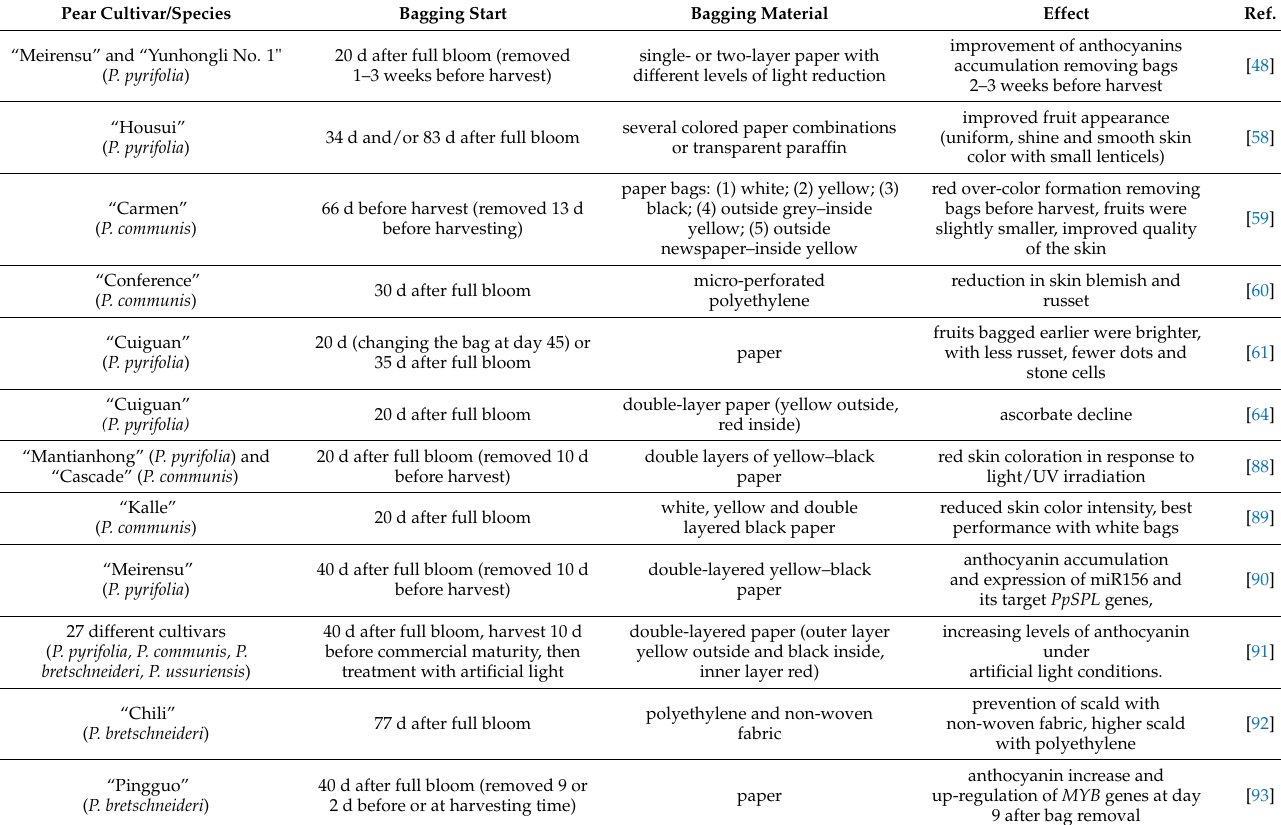
Table 3. The influence of bagging on physiological disorders, color and quality of pear fruits. Pear